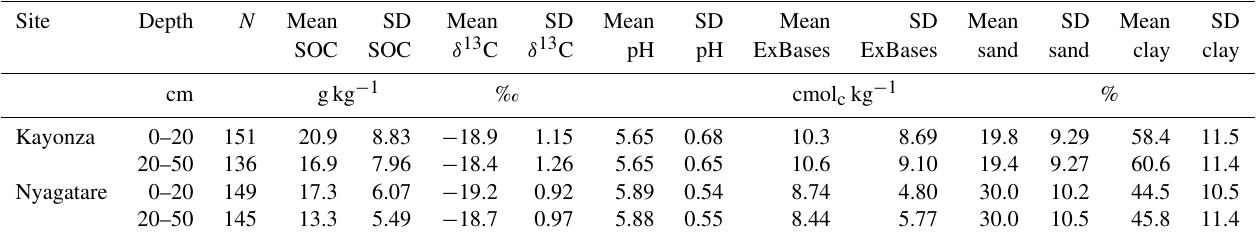
Figure 4. Density plots of soil organic carbon (SOC), clay, exchangeable bases (ExBases), and pH for the topsoil and subsoil samples at the Kayonza and Nyagatare LDSF sites, Rwanda. Table 2. Soil properties for topsoil and subsoil samples at the two LDSF sites (SD: standard deviation; ExBases is exchangeable bases).